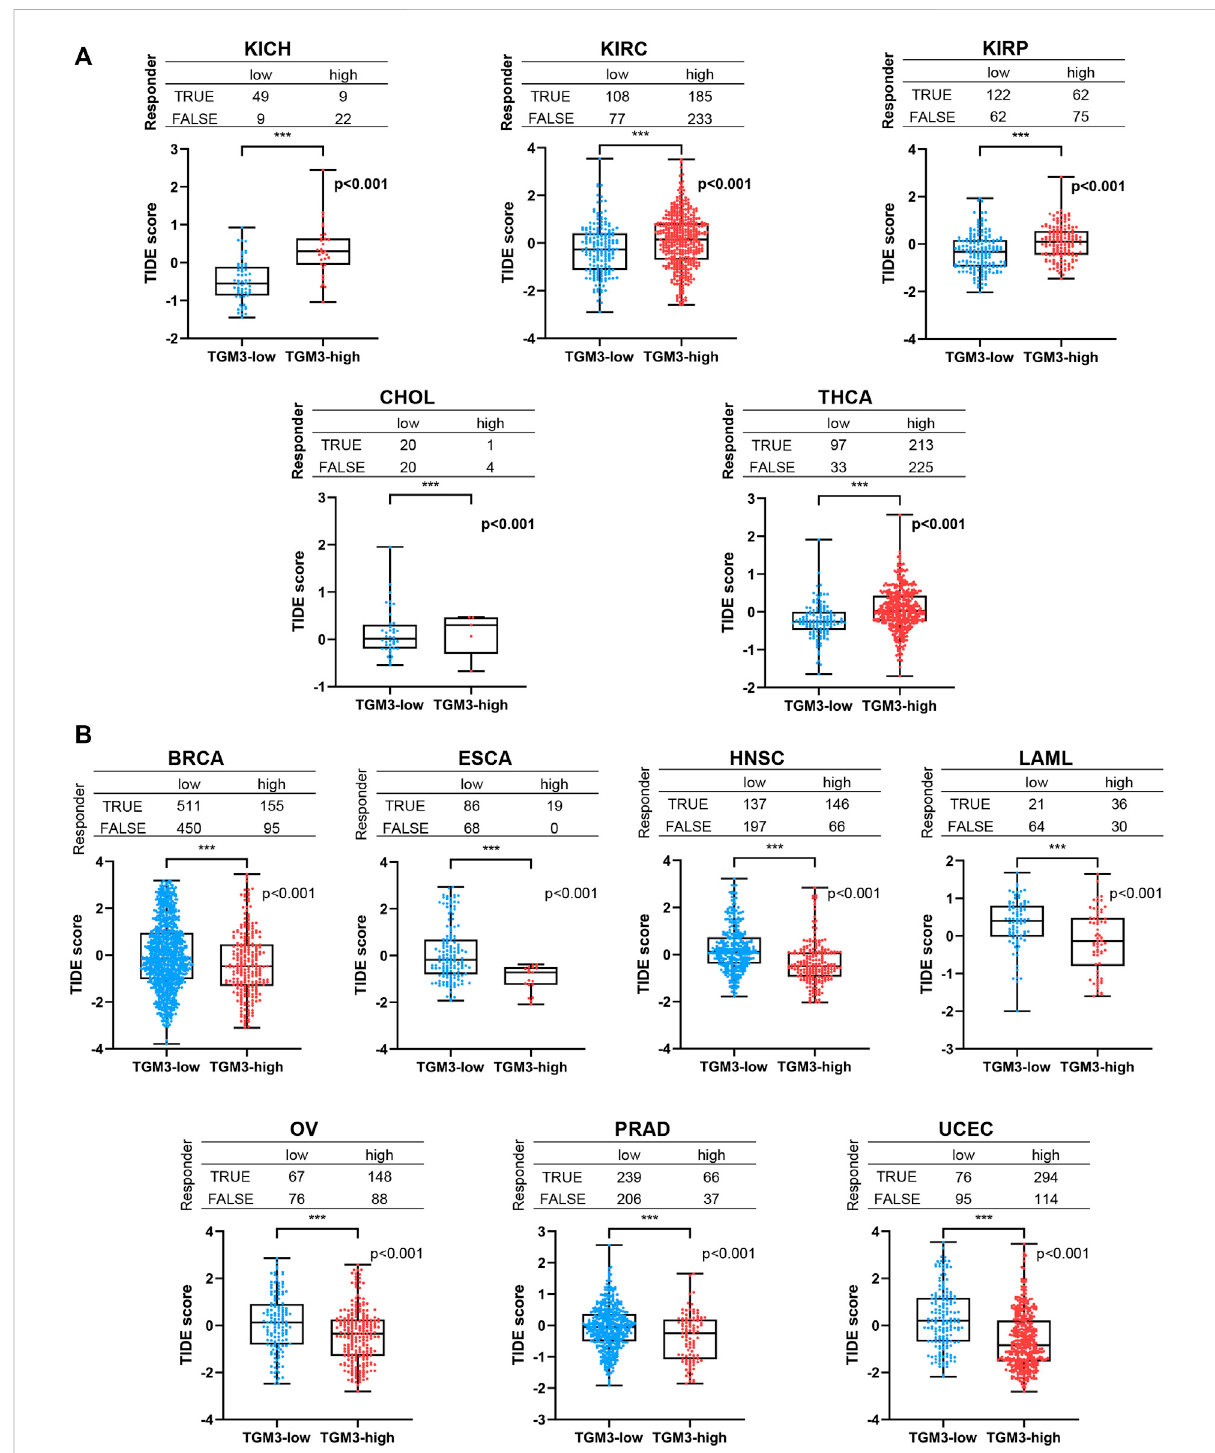
FIGURE 8 The relationship between TGM3 and patient response to ICI therapy. (A) The TGM3-low tumor group had a better therapeutic ICI response in KICH, KIRC, KIRP, CHOL and THCA. (B) The TGM3-high tumor group had a better therapeutic ICI response in BRCA, ESCA, HNSC, LAML, OV, PRAD and